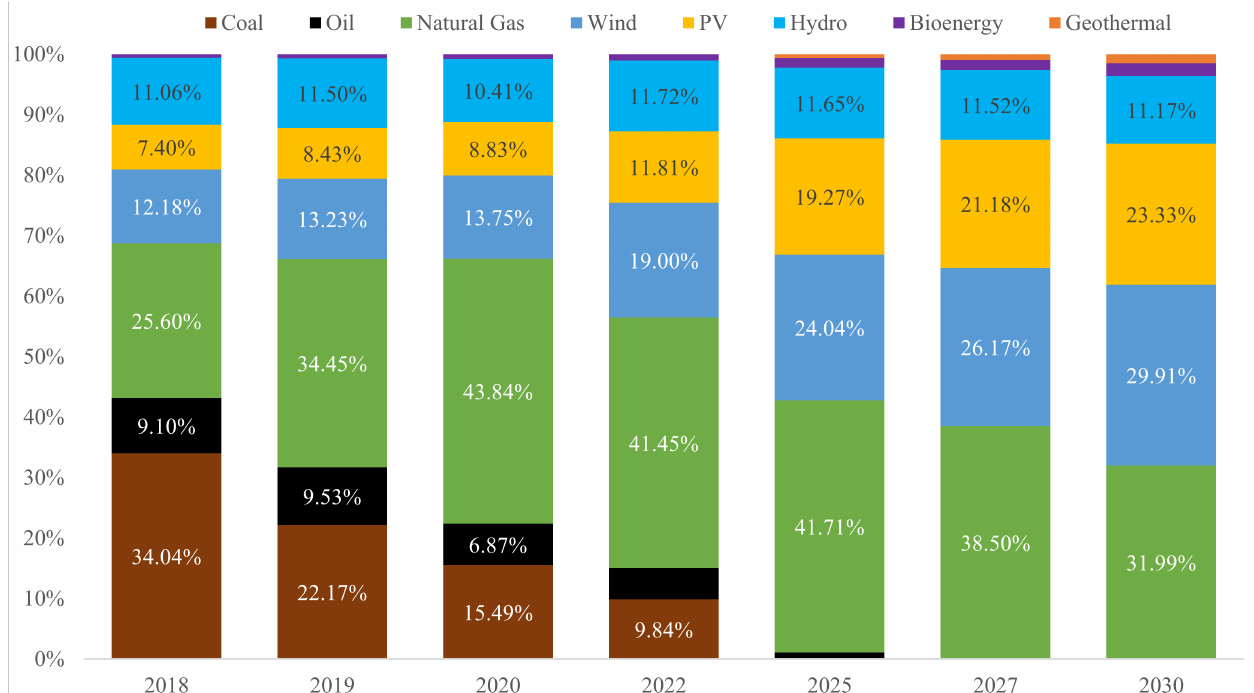
Figure 2. Evolution of Electricity Generation by Source in Greece (%), (2018–2030), Source: National Energy and Climate Plan (2020) and Authors’ estimations.